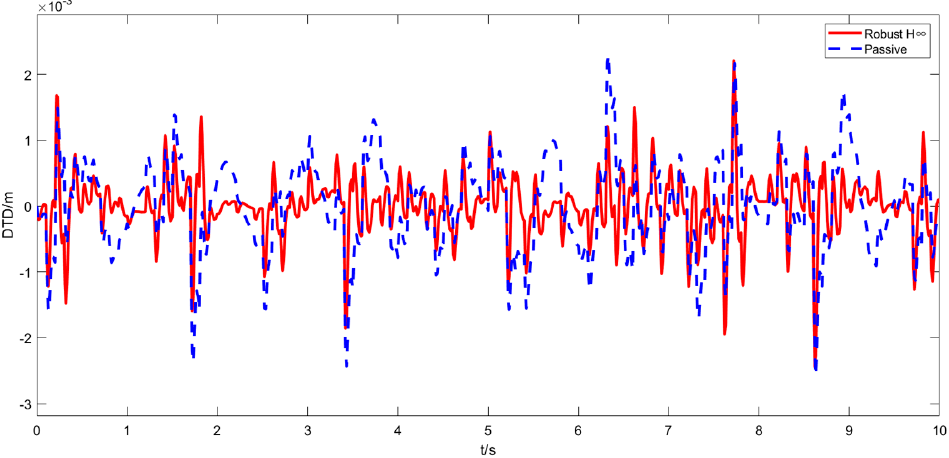
Figure 9. Random road dynamic tire displacement responses of passive and active suspensions.